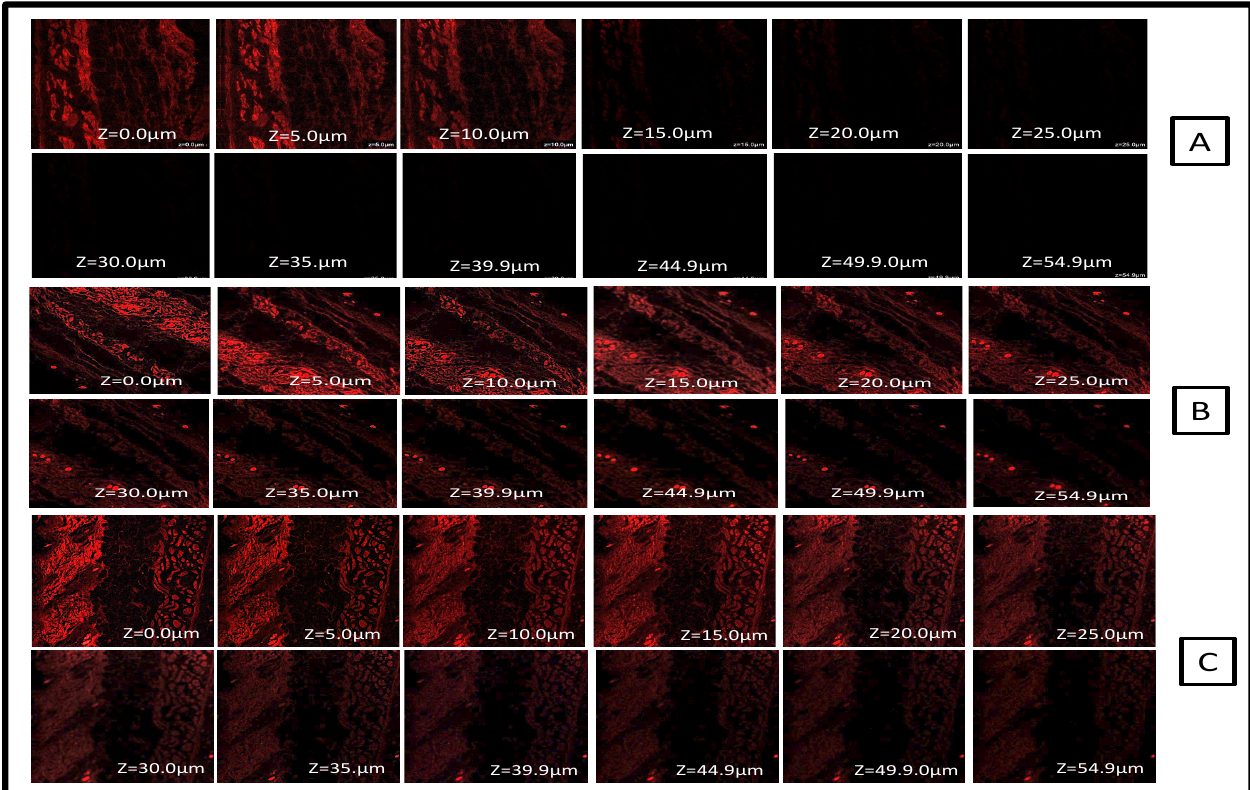
Figure 4 . Confocal laser scanning microscopy in optical sectioning of tissues. ( A ) pure drug TQ ( B ) FTQ-NEG normal skin ( C ) FTQ-NEG with psoriatic skin .